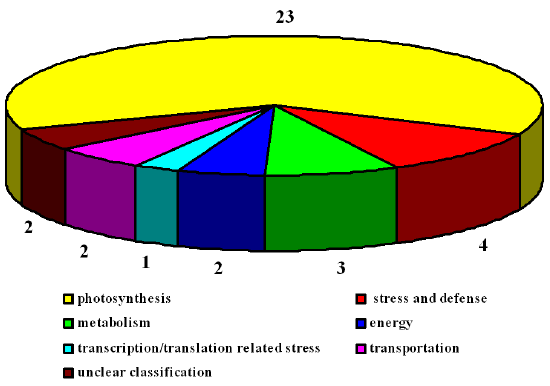
Figure 12. Functional categorization of proteins in R. pseudoacacia tetraploid (4×) plants under salt stress. Digits indicate the protein number of each functional